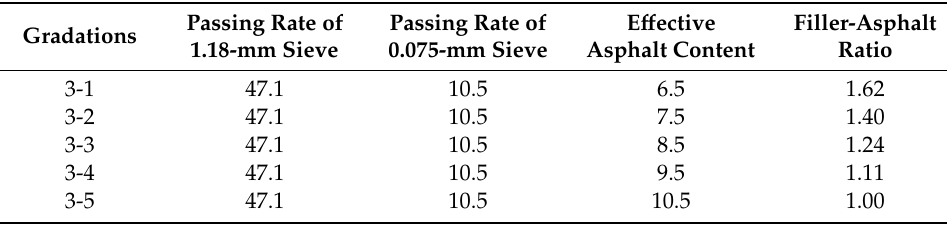
Table 12. Gradations with di ff erent mineral filler